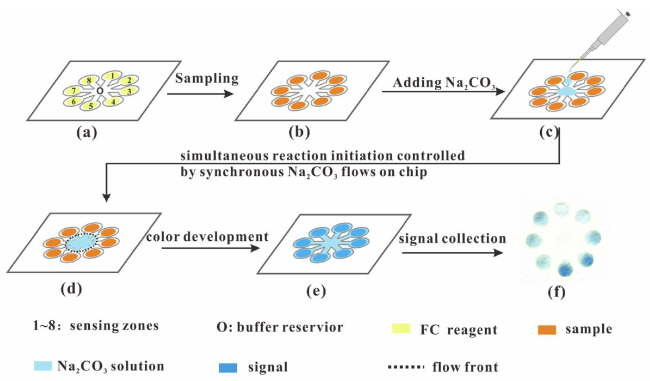
Figure 4. Schematic diagram for the process of rapid determination of total tea polyphenols with paralleled reaction and simultaneous signal acquisition. ( a ): Chips containing FC reagent, ( b ): Add samples, ( c ): Add Na 2 CO 3 in the central region of the chip, ( d ): Simultaneously trigger the FC reaction, ( e ): Obtain the reaction signal, ( f ): Collect signals. Reprinted with permission from ref. [46] . Copyright 2021 Elsevier.